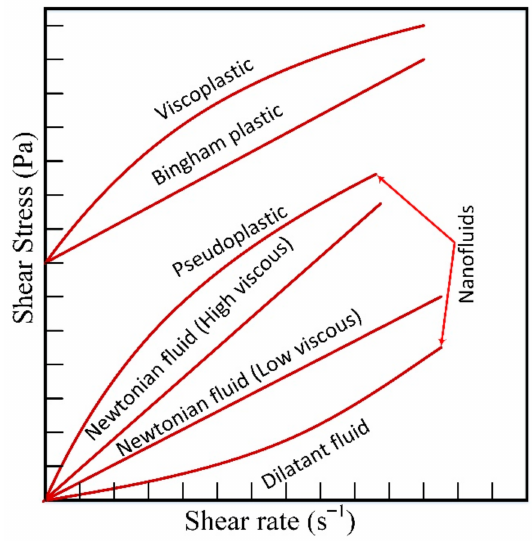
Figure 6. Various rheological behaviors of different